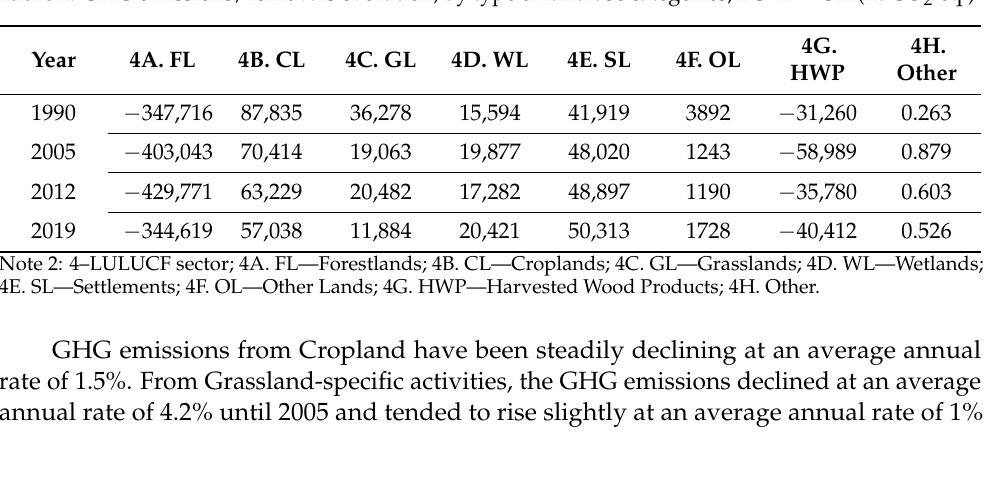
Figure 2. GHG emissions vs. GHG removals dynamics, by GHG type, EU-27 + UK. 1990 = 1. The observed decrease in GHG removals, with an annual average rate of 2.64% per